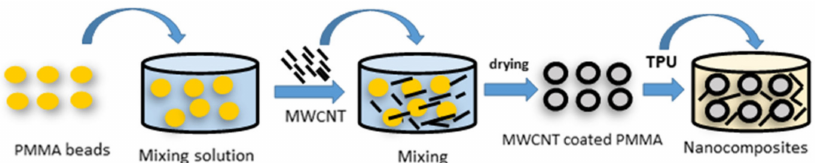
Figure 1. Schematic representation of the fabrication of MWCNT-coated PMMA polymer